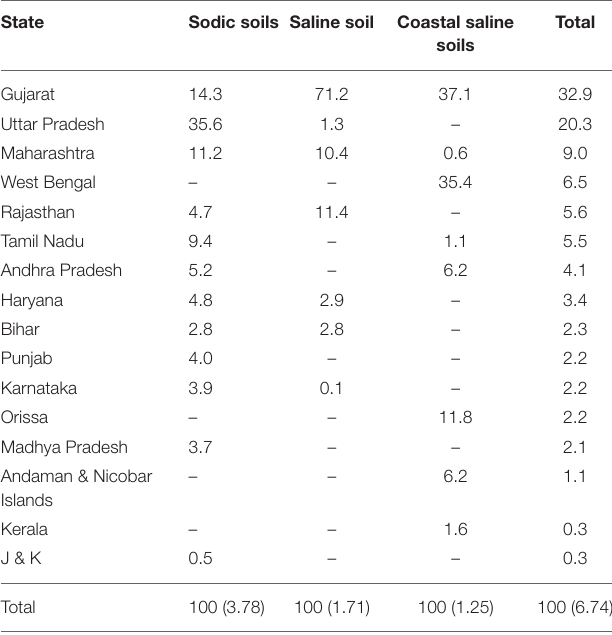
TABLE 3 | State-wise share (%) of salt-affected soils in